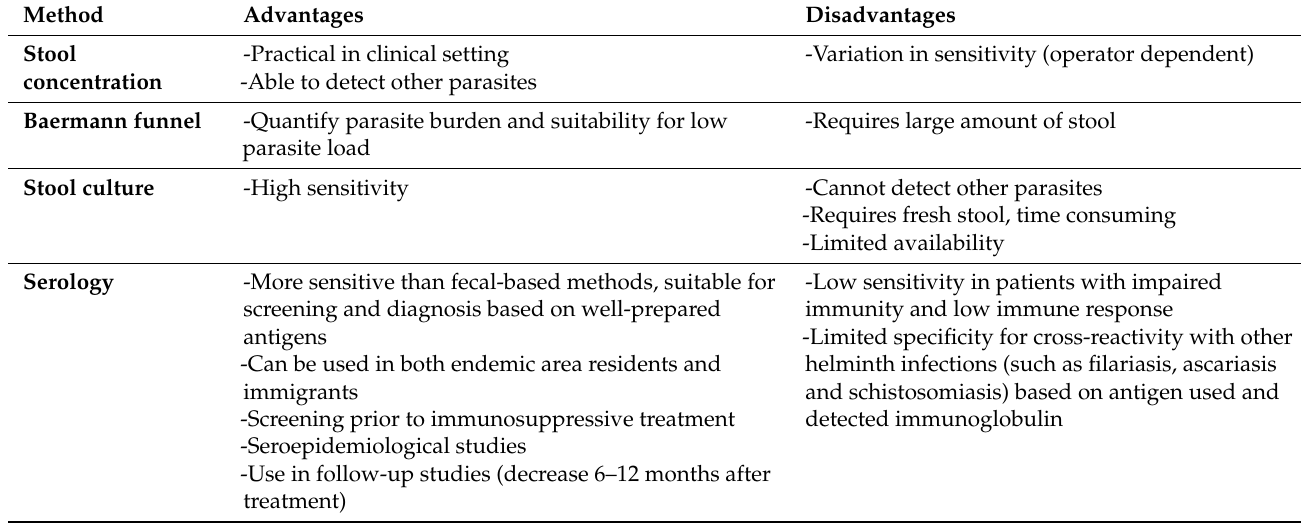
Table 1. Summary of diagnostic tests for strongyloidiasis.